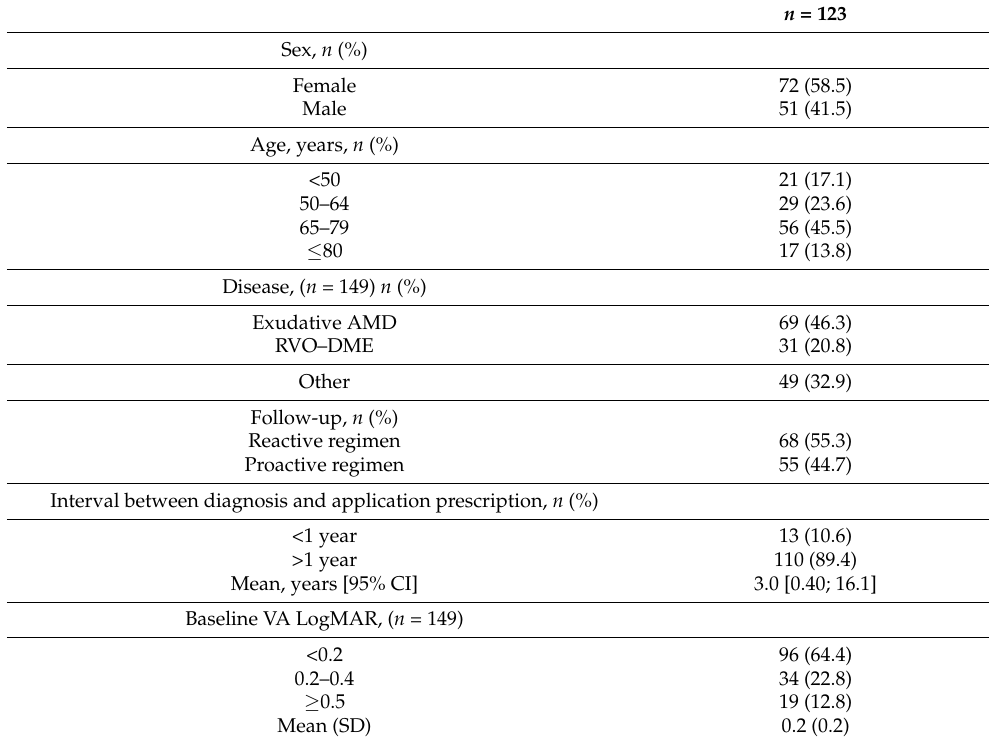
Table 1. Patient characteristics.